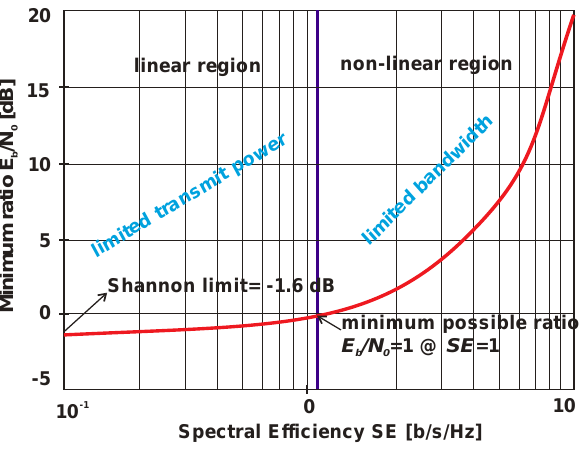
Figure 2. Spectral efficiency (SE) and energy efficiency (EE) (Eb/N0) relationship.